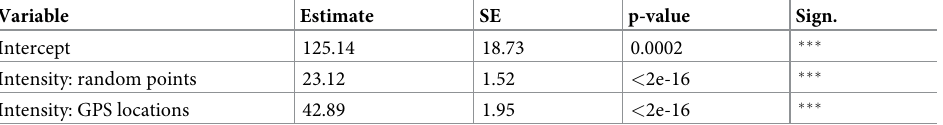
Table 3. Linear mixed-effects model explaining distance of GPS locations and random points towards closest nearby routes depending on the intensity of human activity. Variable